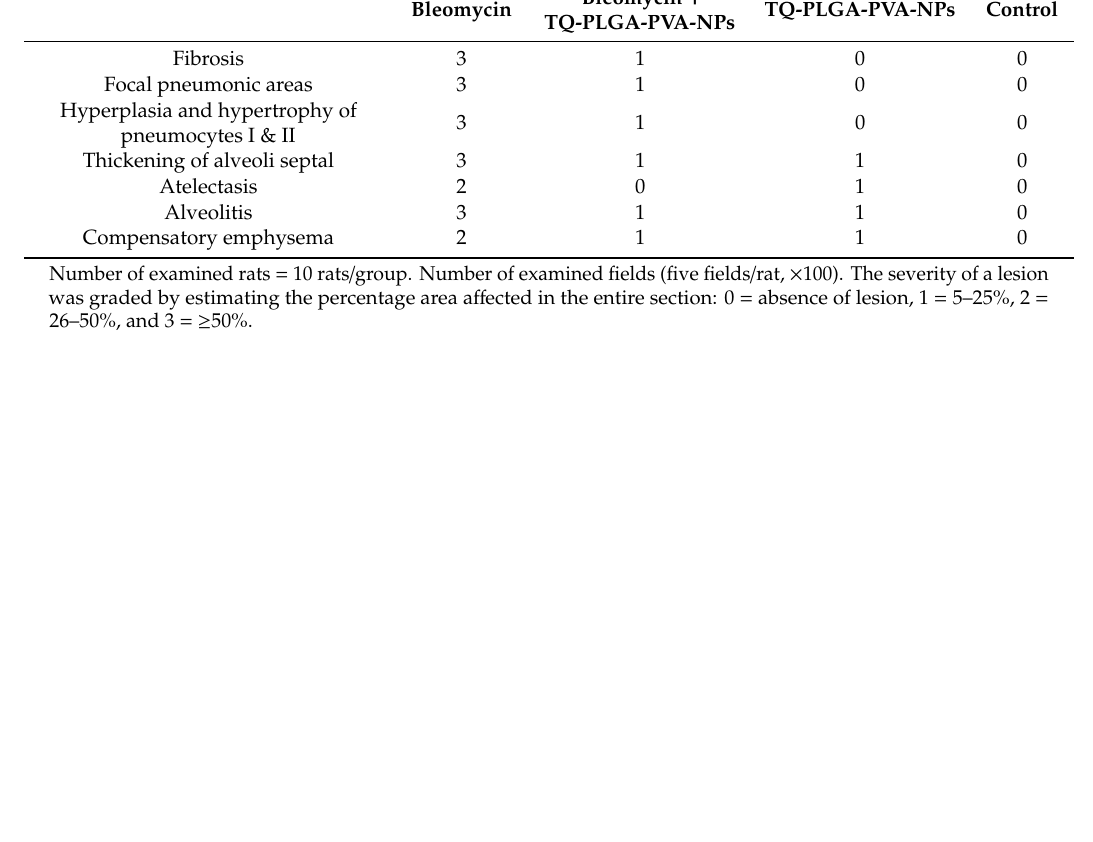
Table 1. The severity of histopathological lesions recorded in the lung tissues of male Wister albino rats treated with bleomycin, TQ-PLGA nanoparticles, or their combination. Scored